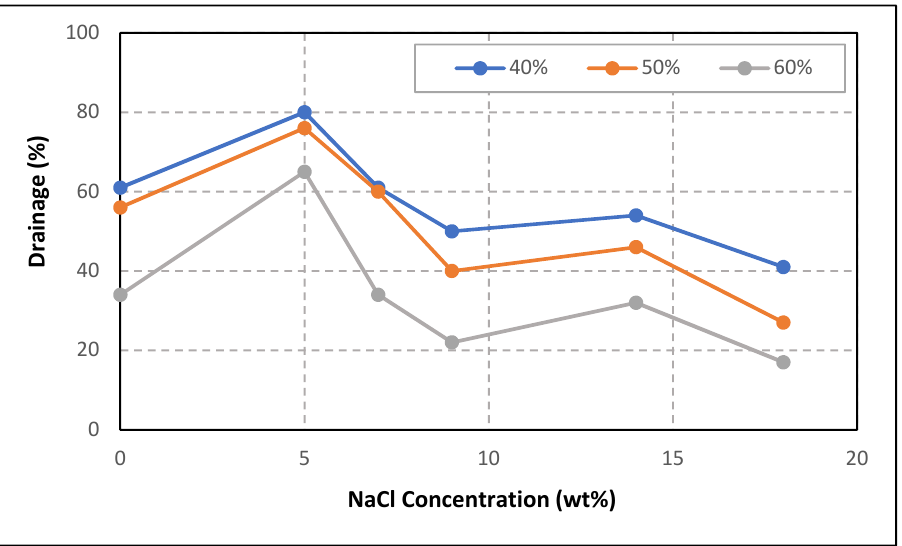
Figure 8. Final average drainage (AVE) vs. NaCl content for different quality foams.